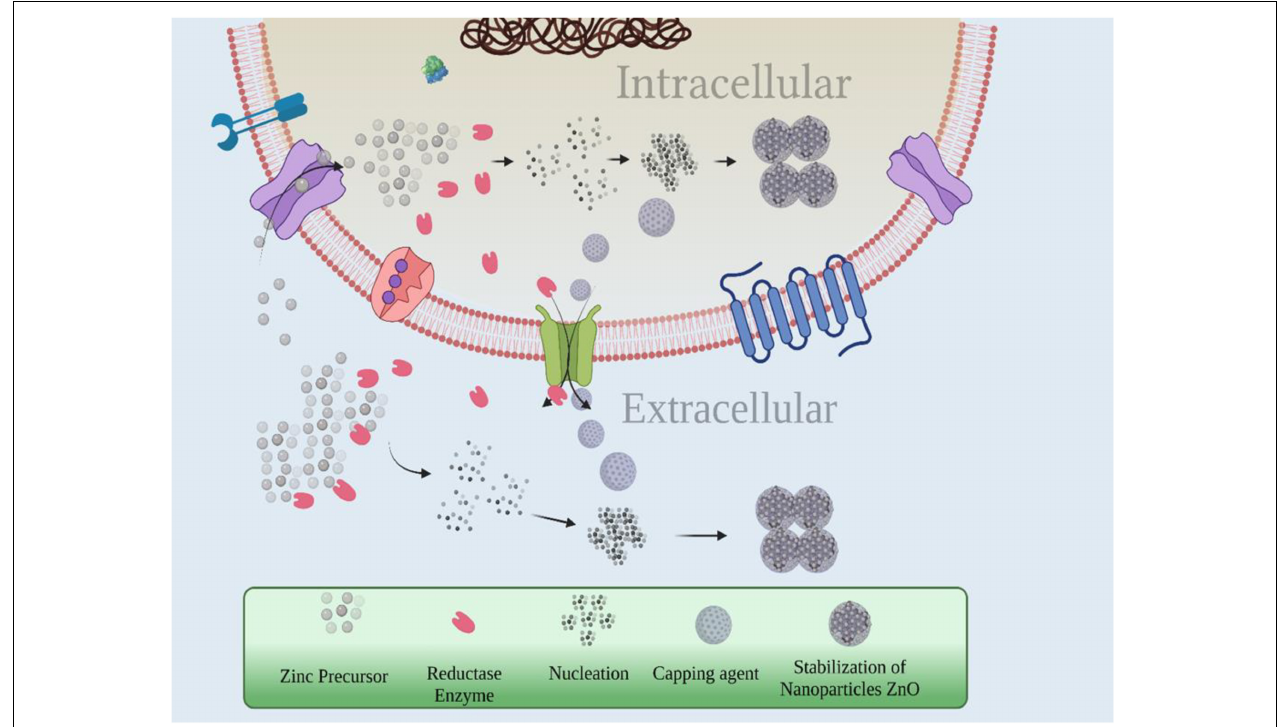
FIGURE 3 | Mechanism of microbe-mediated synthesis of